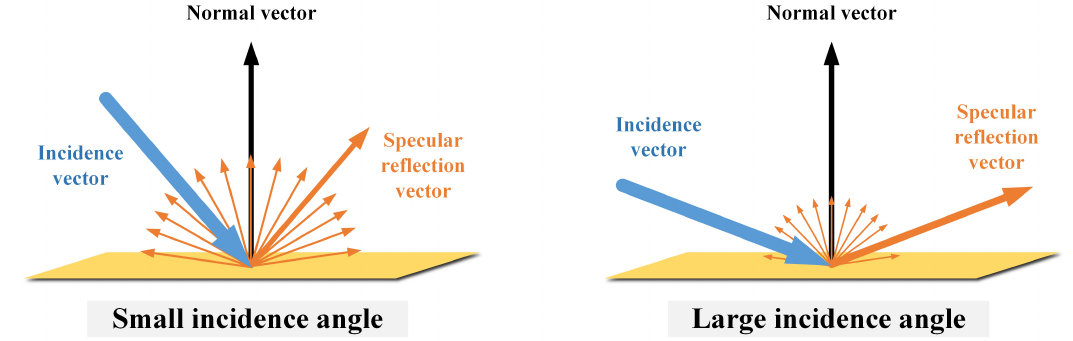
Figure 2. Schematic of the Fresnel effect. When the incidence angle of light on the surface is larger, the specular reflection component is stronger, and the diffuse reflection component is weaker.